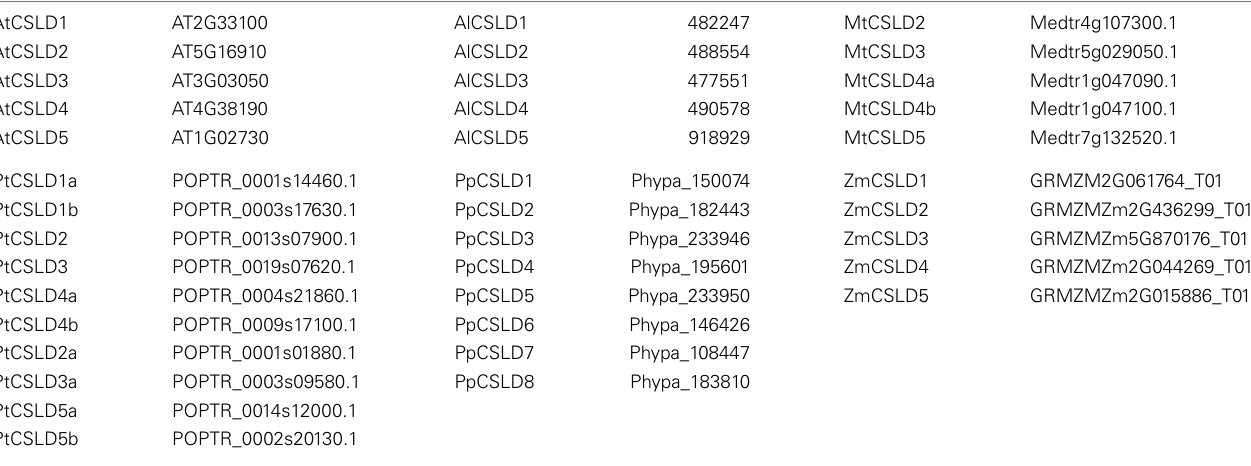
TableA1 | Nomenclature of CSLD genes and their corresponding accession numbers inTAIR and